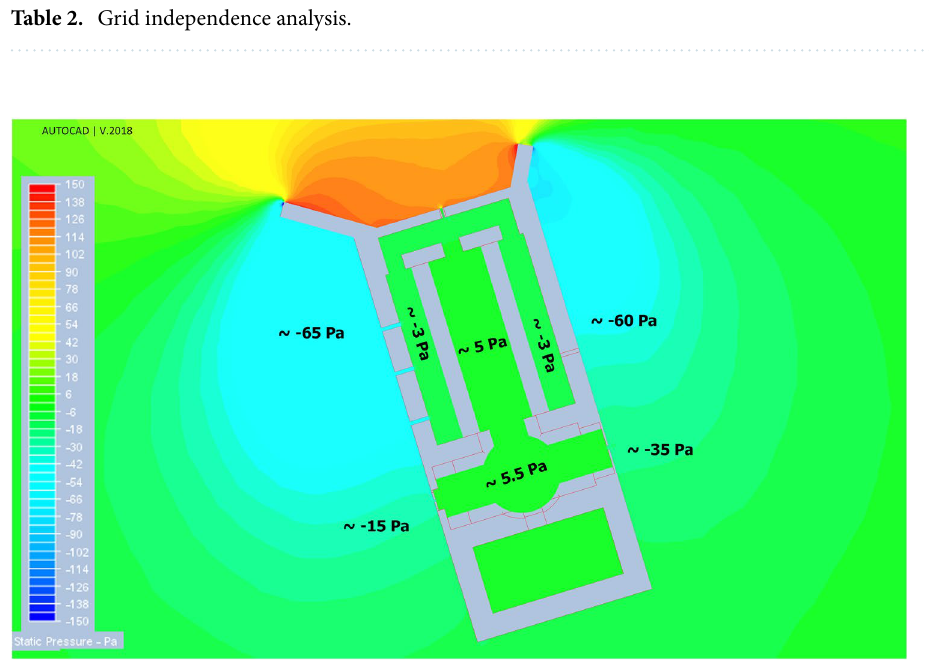
Figure 10. Pressure distribution around and inside the